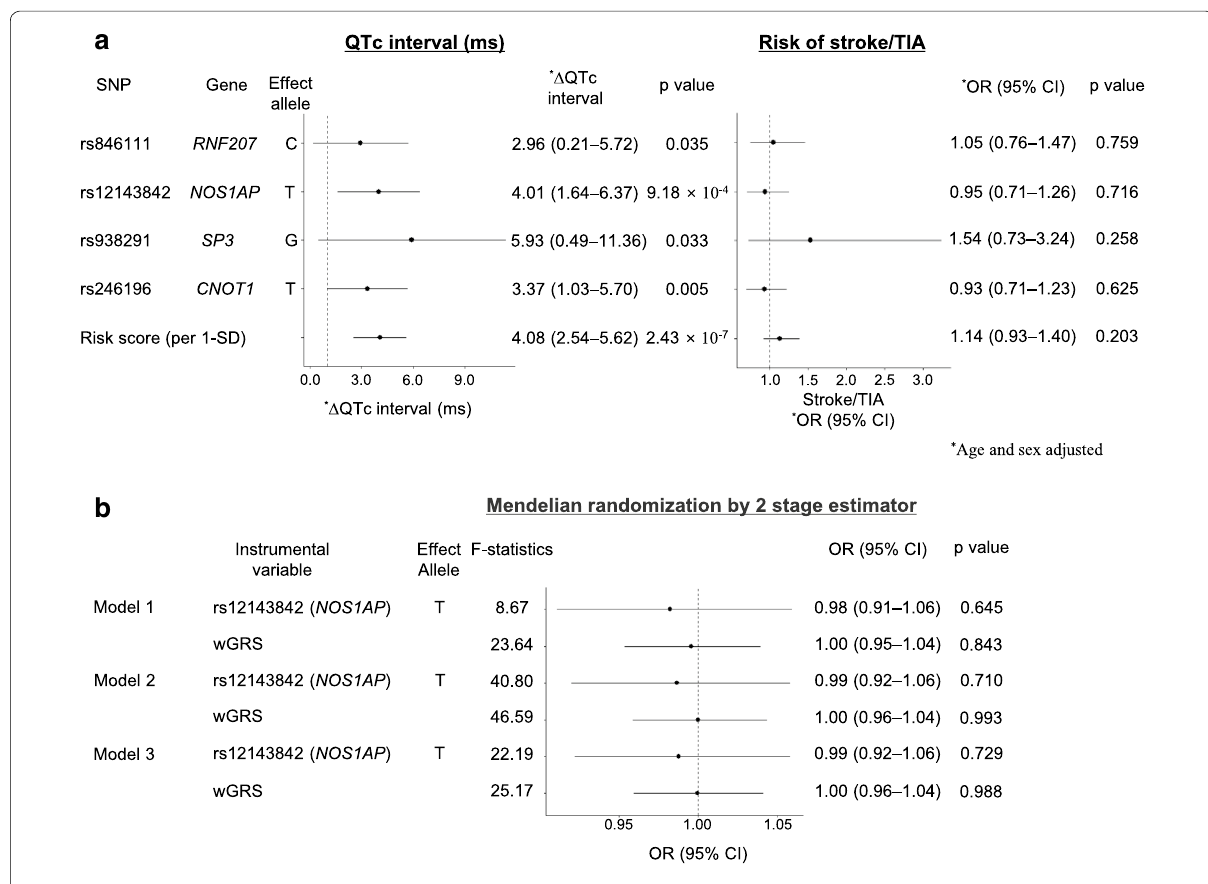
Fig. 2 The causal association of the QTc interval on a stroke/TIA. a Association of four genetic variants and the weighted genetic risk score (wGRS) with the QTc interval (exposure) and a stroke/TIA (outcome). b The results of the one‑sample Mendelian randomization in the top SNP rs12143842 ( NOS1AP at 1q23.3) and wGRS for the 4 SNPs